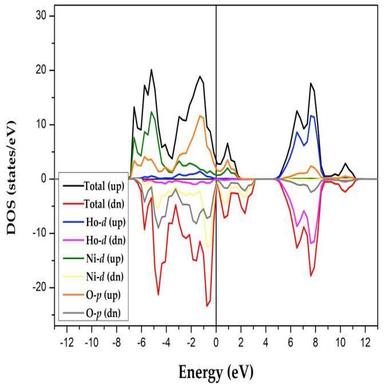
Total and projected density of states of the R3c HoNiO3 material.